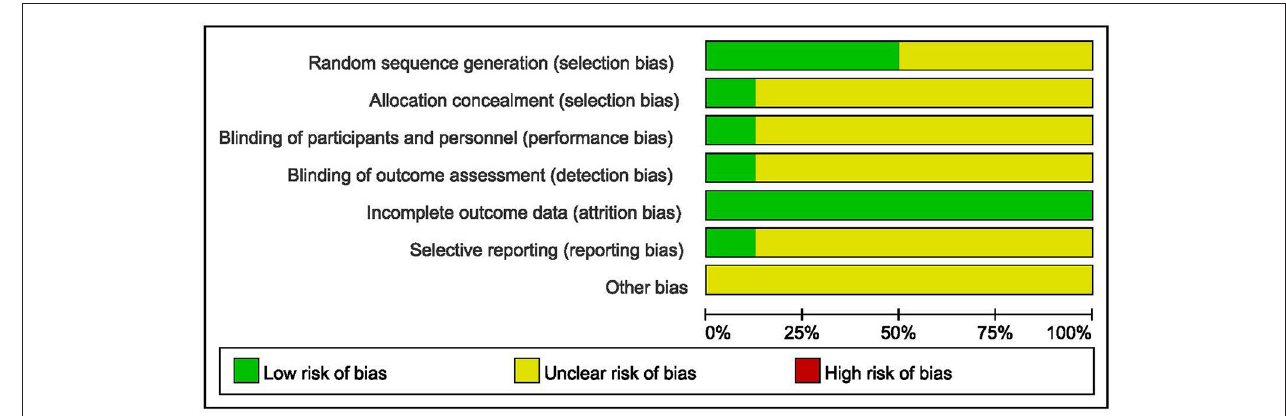
FIGURE 2 | Risk of bias